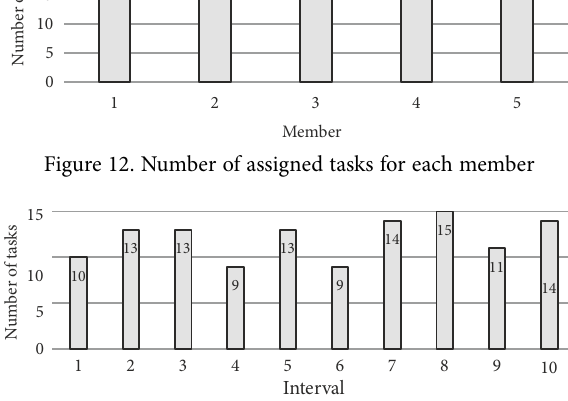
Figure 13. Number of assigned tasks in each interval